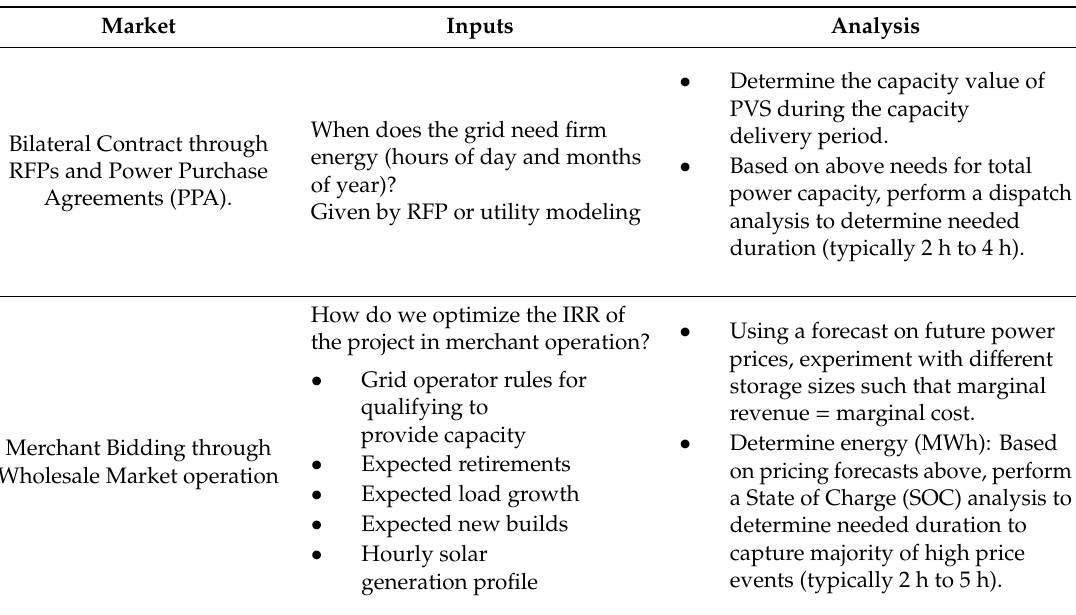
Table 2. General framework for inputs and analyses of utility-scale PV plus battery storage systems (PVS) based on market type and characteristics in the